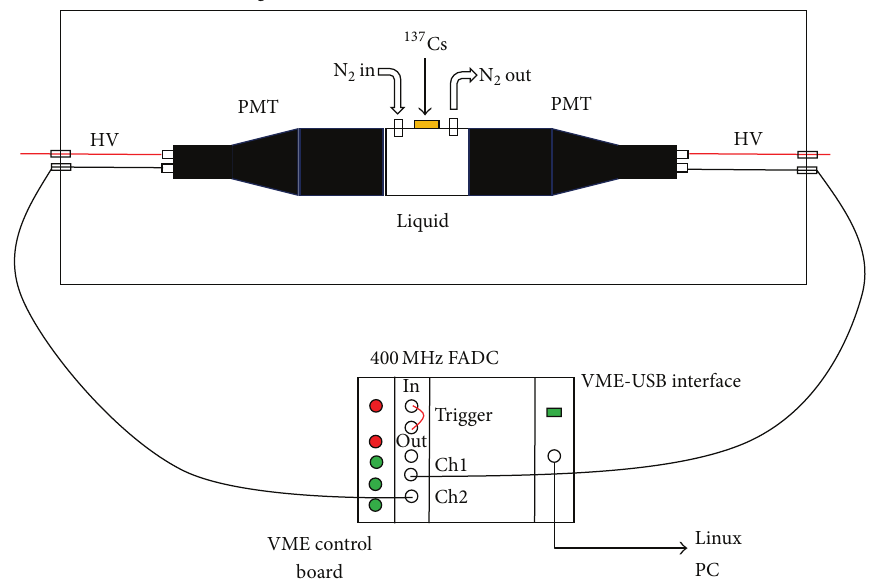
Figure 4: Schematic layout of the experimental test setup for DAQ. A homemade FADC-based DAQ system is designed. A self-trigger in the FPGA chip on the FADC module is used. A built-in discriminator with an adjustable 10mV threshold is applied. Data are transferred to Linux-based operating computer through VME-USB interface.